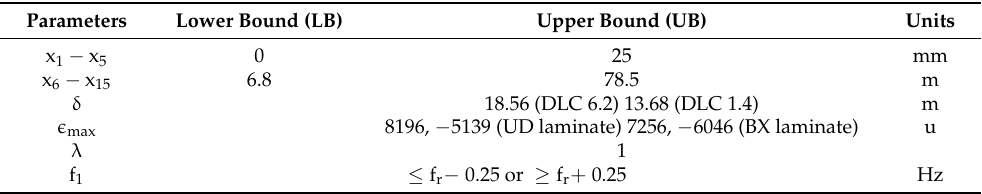
Table 6. Summary of bounds and constraints.